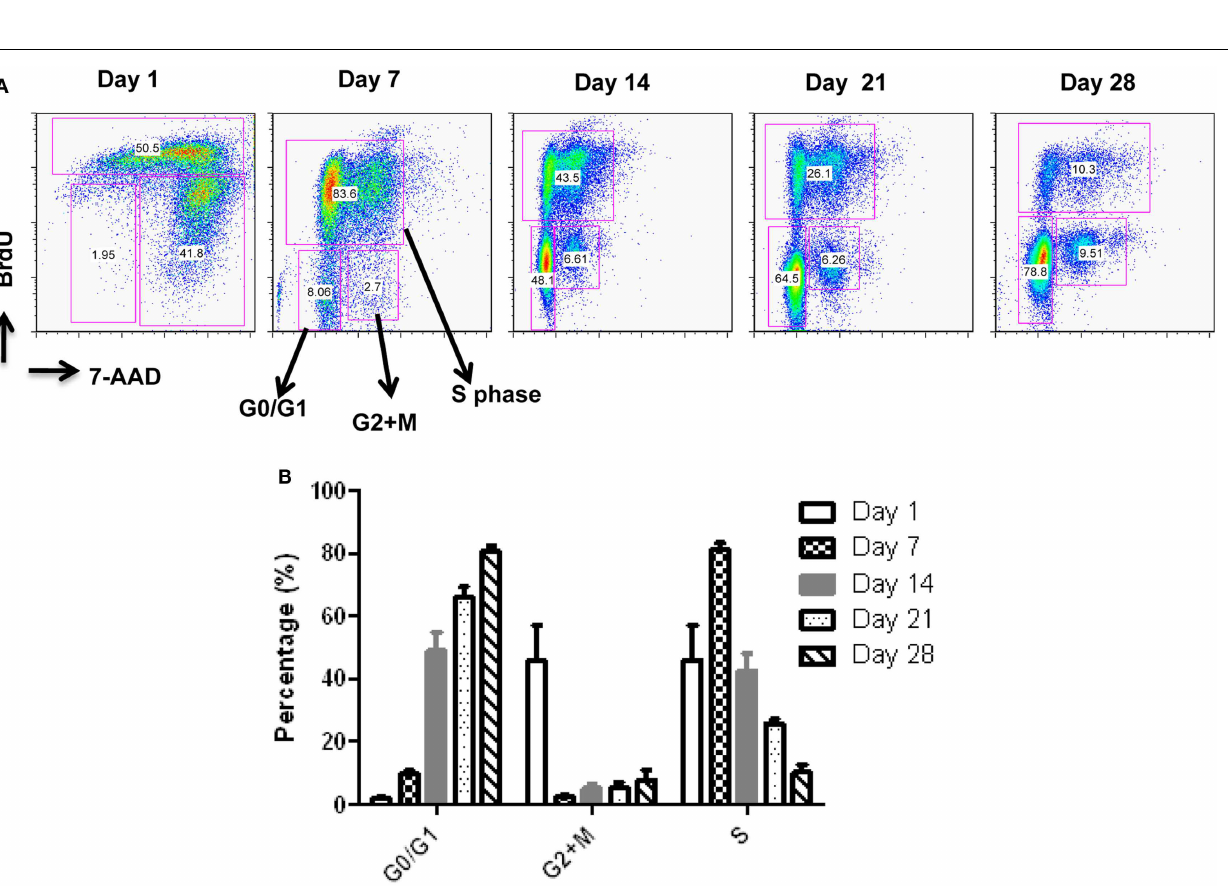
of expanded pNK cells against tumor lines was